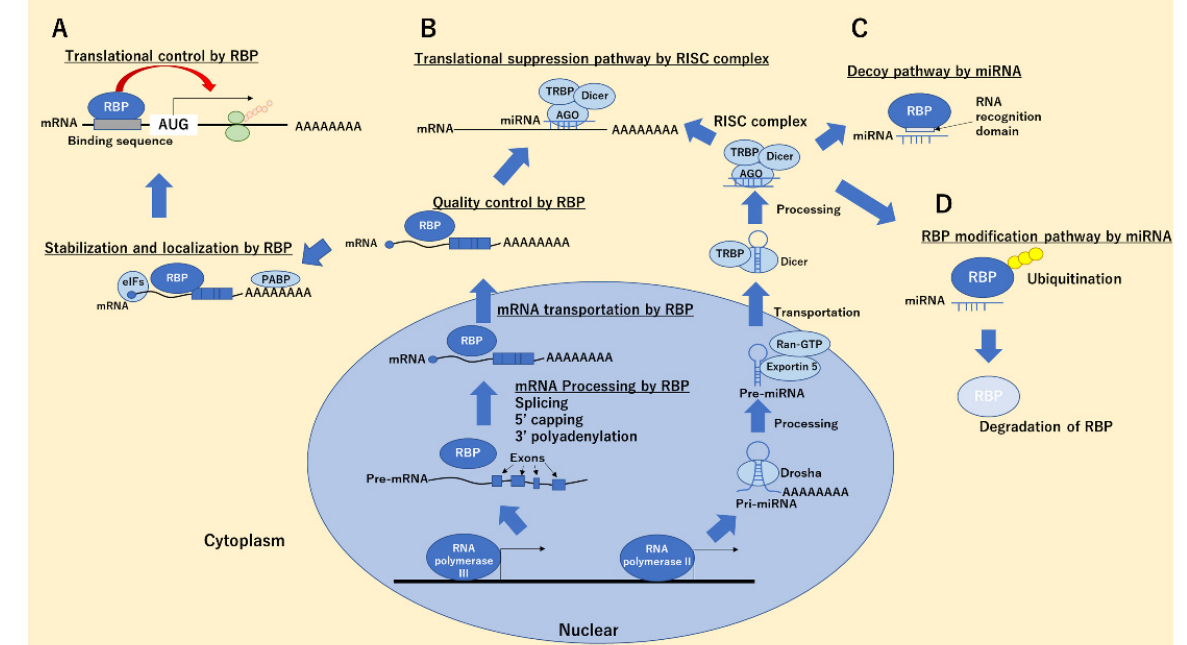
Figure 1. Working system of microRNA (miRNA) targeting RNA-binding protein (RBP). RBPs support the regulation of translation by binding to messenger RNAs (mRNAs) ( A ). Conversely, microRNA (miRNA)-containing RNA-induced silencing complexes (RISCs) suppress the translation through the sequence-dependent binding to mRNAs ( B ). Some miRNAs, which have similar sequences with RNA-binding domains of RBP, can be decoy mRNA and interfere with the translation mediating the RBP–mRNA binding ( C ) and induce RBP ubiquitination mediating the direct binding ( D ).